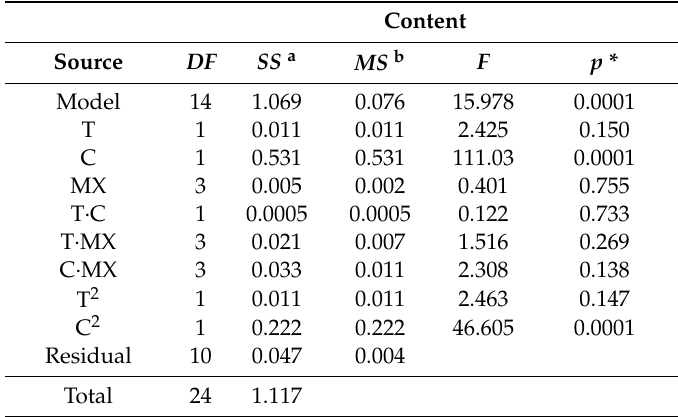
Table 3. ANOVA results determined for content of antioxidant in